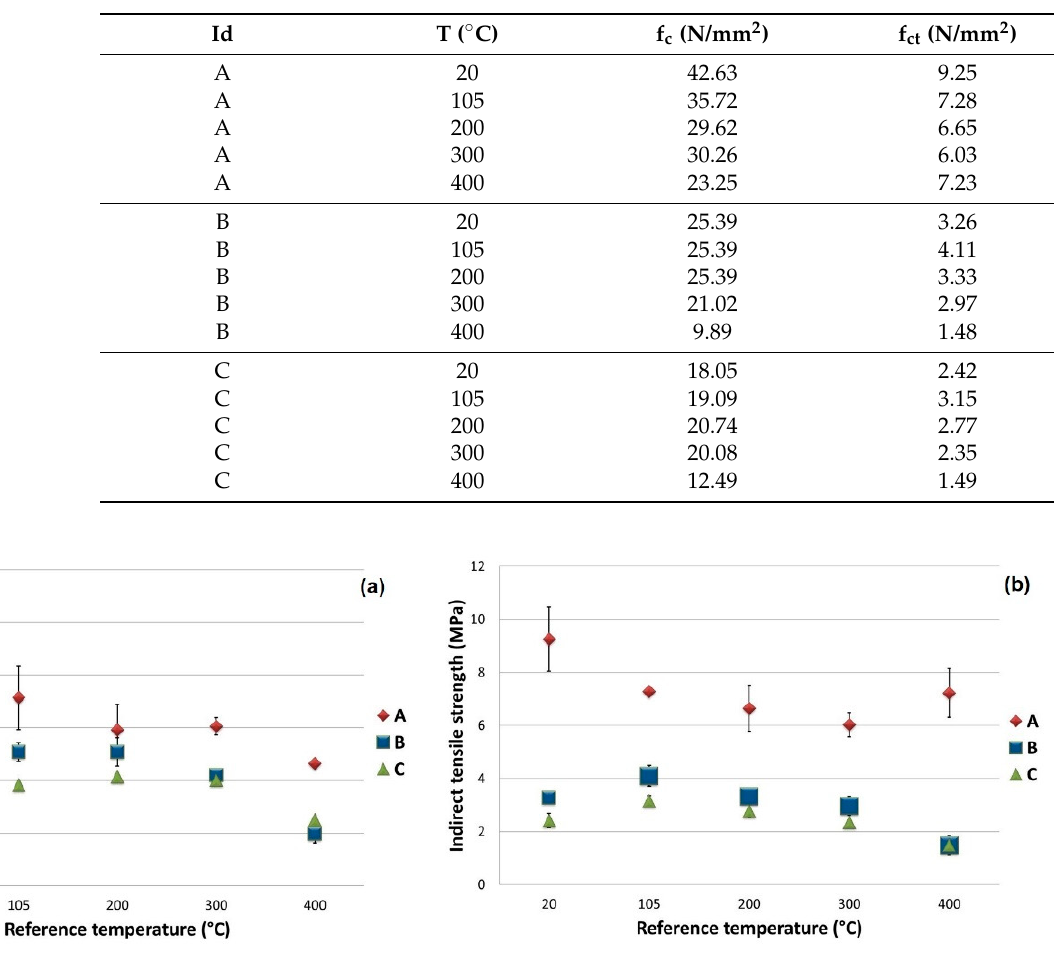
Table 6. Compression and indirect tensile strength for the concrete mix designs as a function of heat treatment temperature.